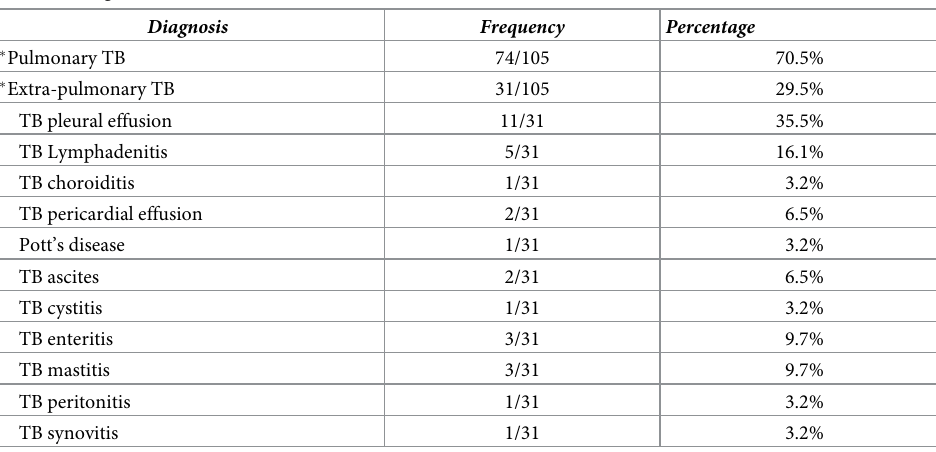
Table 2. Diagnosis of the included TB